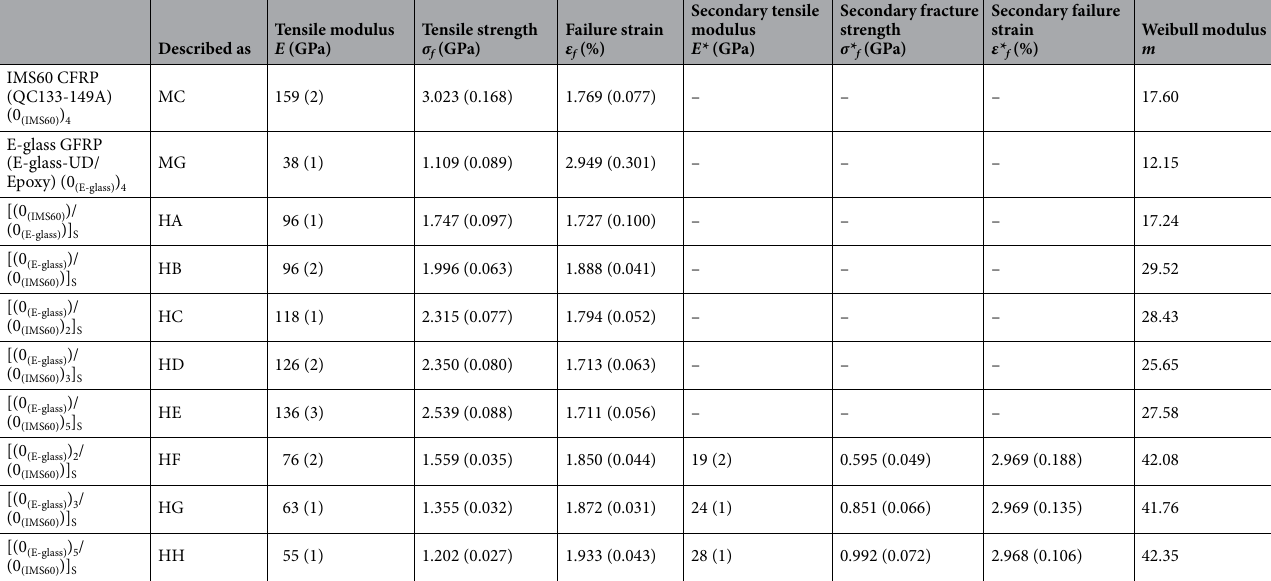
Table 2. Tensile properties of the mono CFRP and GFRP, and HFRP specimens. (–) indicate standard